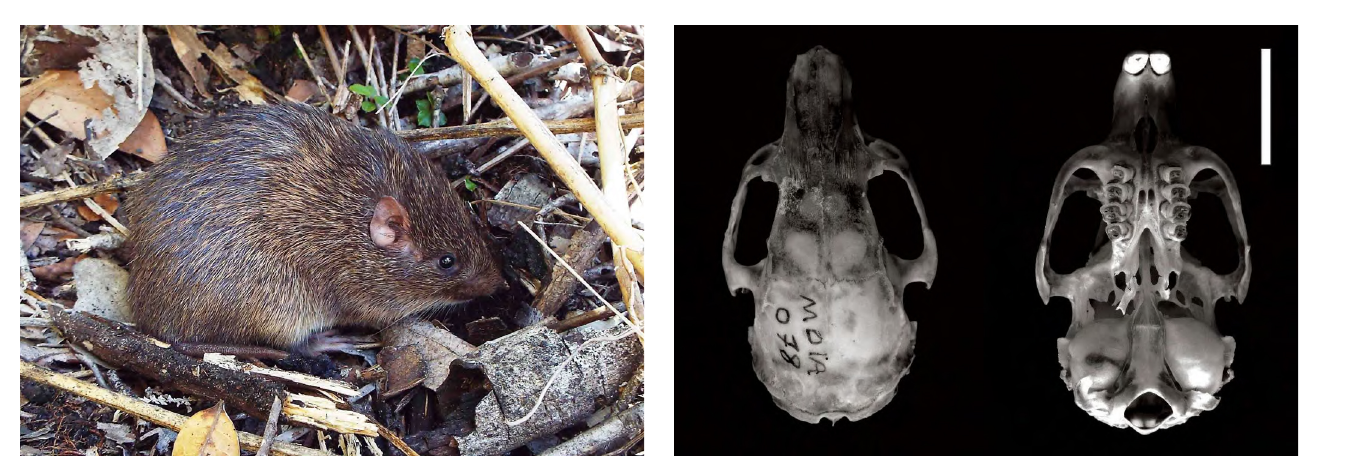
Figure 3. Adult male (age class 6) of Euryzygomatomys spinosus (MDIA078) from Sempre Vivas National Park, northern Minas Gerais, Brazil. Photo by Pacheco MAC.